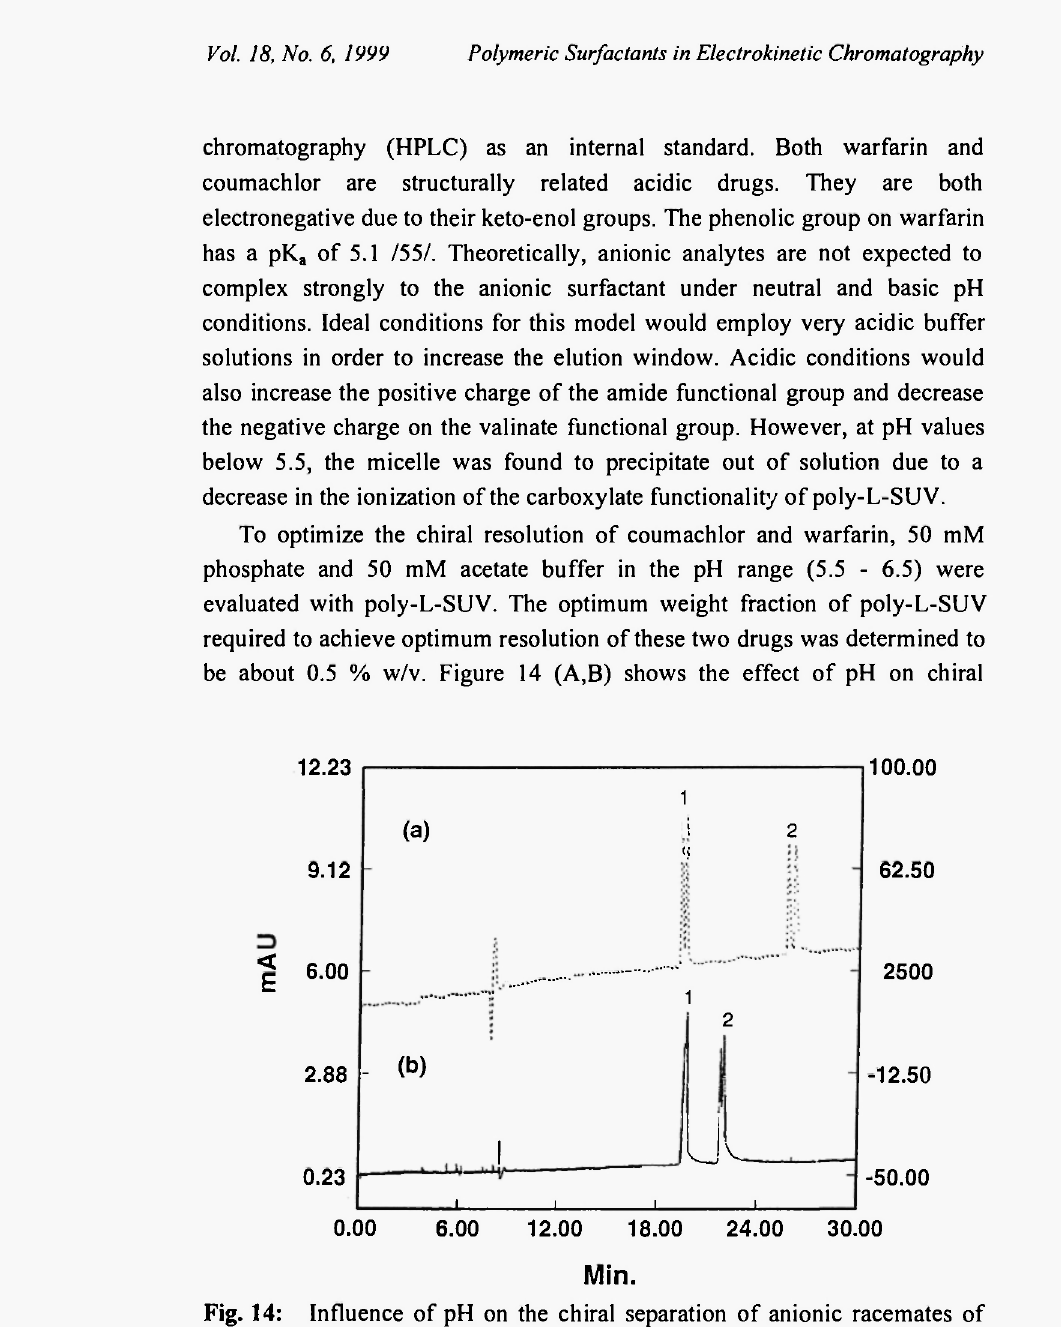
Fig. 14: Influence of pH on the chiral separation of anionic racemates of warfarin (1) and coumachlor (2). CE conditions: buffer 0.5 % w/v Poly-L-SUV with 25 mΜ monobasic phosphate at (a) pH 5.6 and (b) pH 6.5. Other conditions as in Figure 21. From /54/ with